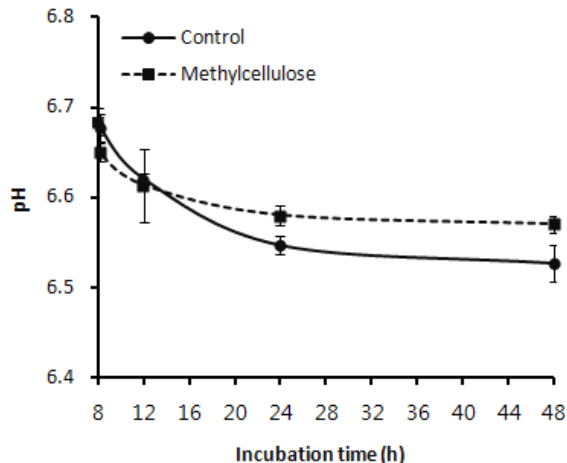
Figure 5. Change in pH as influenced by methylcellulose addition after 8 h of incubation.